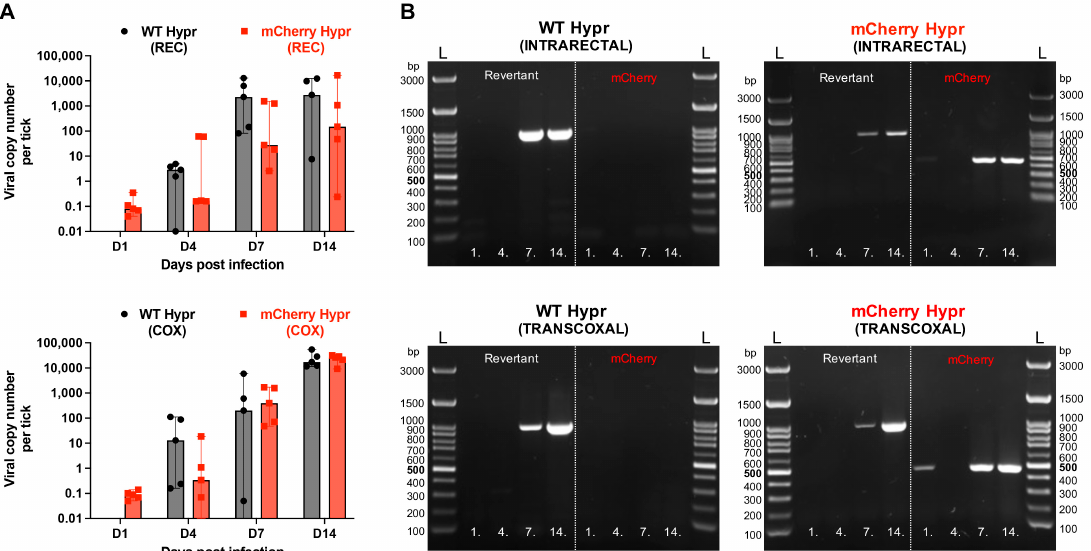
Figure 4. Detection of viruses in experimentally infected ticks by RT-qPCR and RT-PCR. ( A ) Median viral load in ticks (n = 5) inoculated intrarectally (REC) or transcoxally (COX), with error bars showing 95% confidence intervals. ( B ) Agarose gel electrophoresis of mCherry or viral wild-type genome (revertant) PCR products from REC- or COX-inoculated ticks incubated at 1, 4, 7, and 14 days post-infection (dpi). The L-molecular ladder is